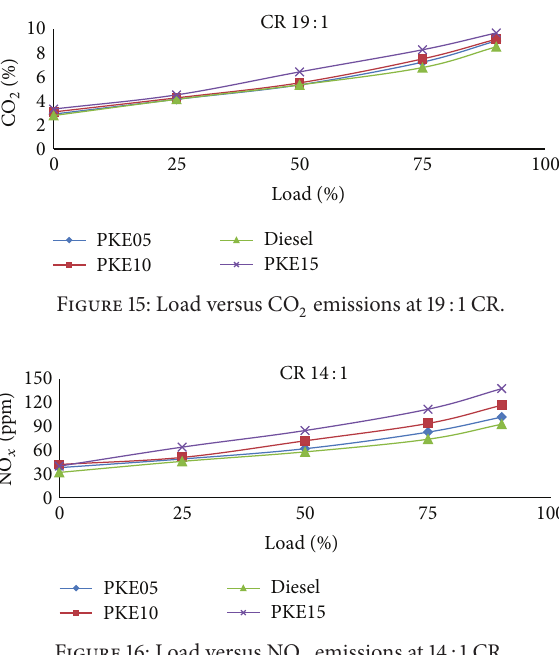
Figure 11: Load versus HC emissions at 16.5: 1 CR.